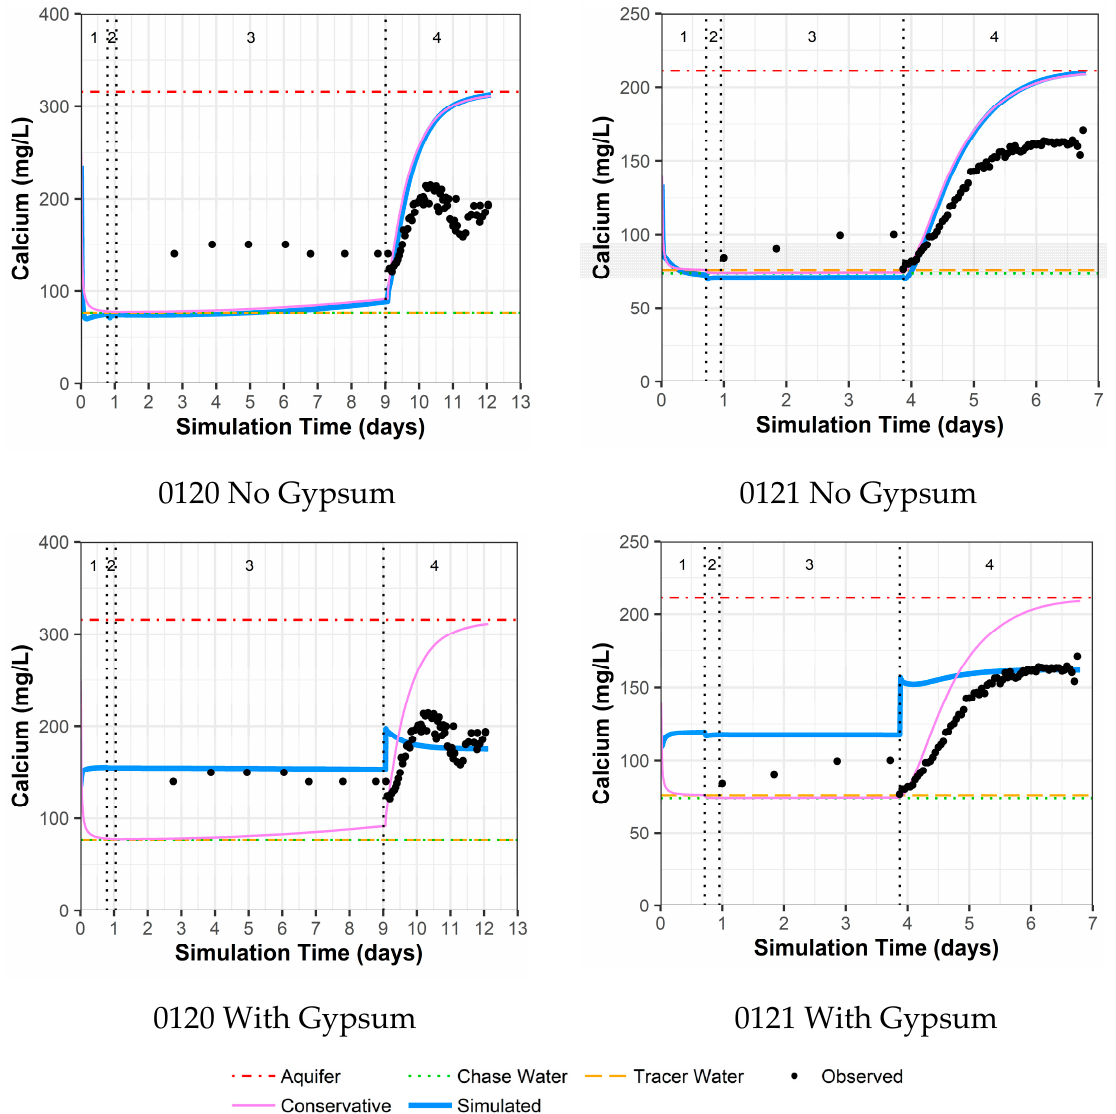
Figure 7. Model fit for calcium with a multilayer approach. Phases are: (1) traced river water injection, (2) untraced river water injection (chase), (3) drift phase, and (4) pumping phase.